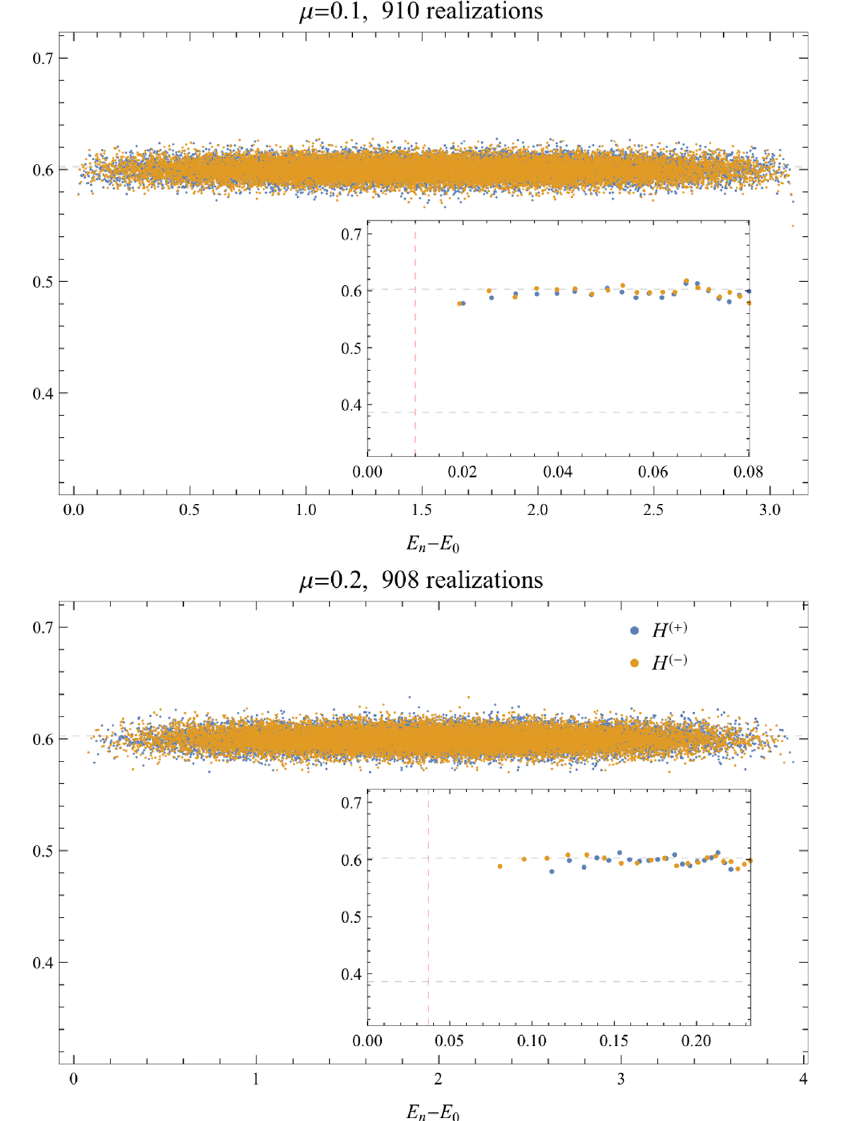
Figure 16 . Adjacent gap ratio